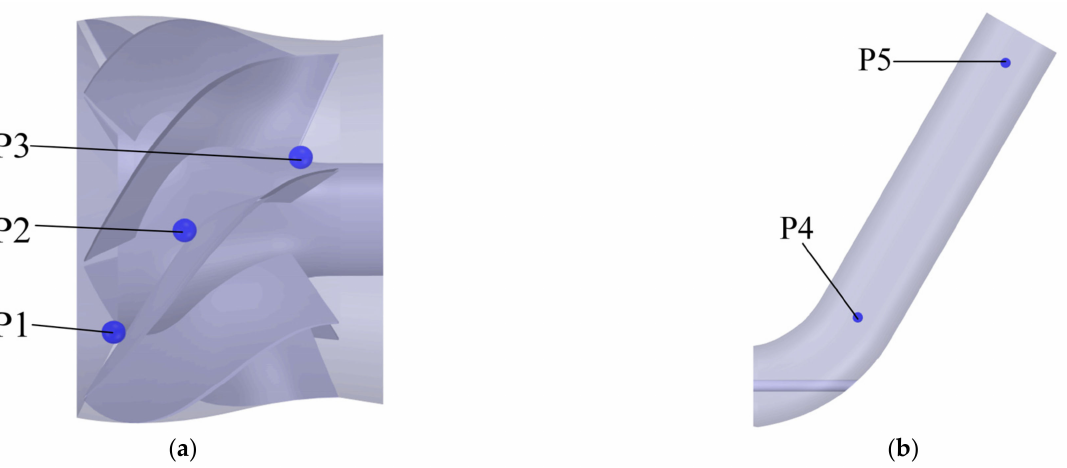
Figure 13. Schematic diagram of monitoring points. ( a ) Monitoring points in guide vane;